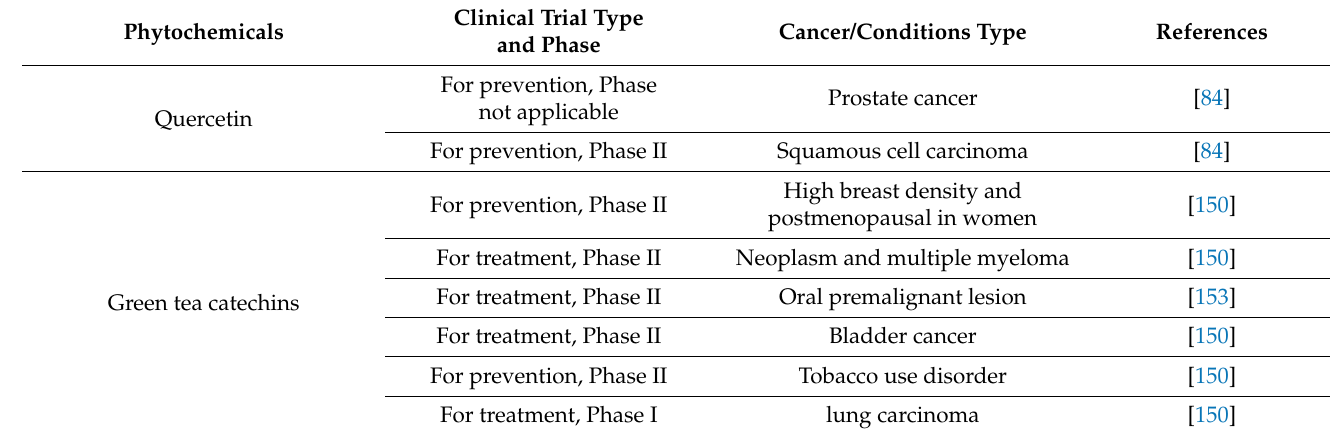
Table 1. A list of phytochemicals as anticancer agents for different cancer in clinical